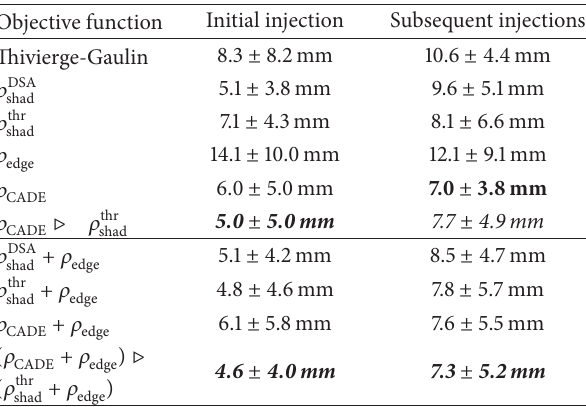
+ 𝜌 Figure 9: Average registration errors of 𝜌 depending on CADE edge the position of the frame after start of the contrast agent injection calculated over all sequences. Frame 1 denotes the first frame which contained contrast agent. The average error at the second frame after the CA injection was 11.8mm ± 9.5 mm; the average error at the fifth frame was 5.5 mm ± 3.0 mm. The frame rate of all sequences was 7.5 fps. Assuming a heart rate of 60bpm, one heart cycle takes approximately 7 frames. So a first portion of CA is ejected into the ventricle not later than at the 7th frame. Note that the number of sequences used for calculation was not constant for each frame number as several sequences had fewer than nine contrasted frames. Table 2: Translation errors for a single automatically chosen frame as described in (14) and (15).